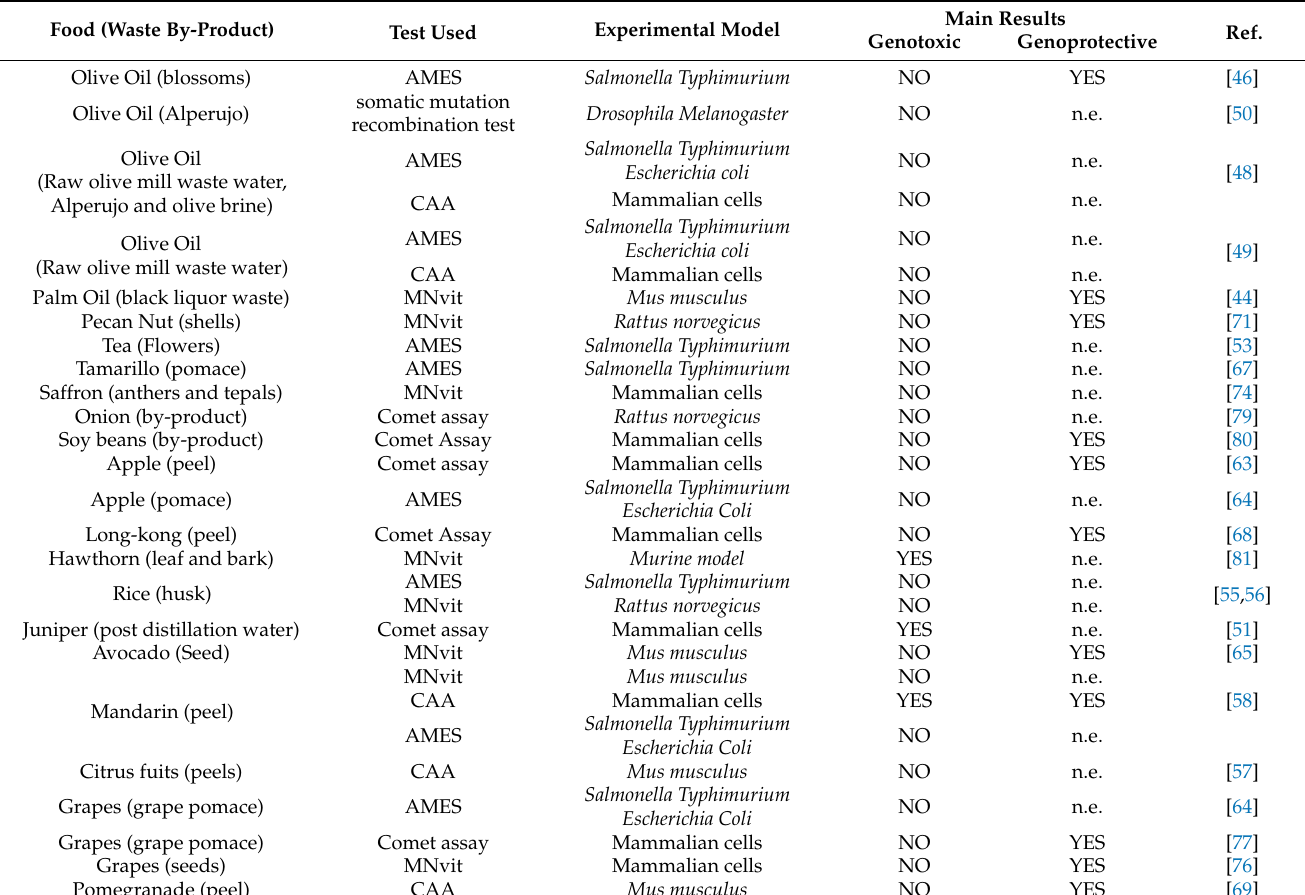
Table 1. Studies assessing the genotoxicity of bioactive fractions obtained using biowaste as a raw starting